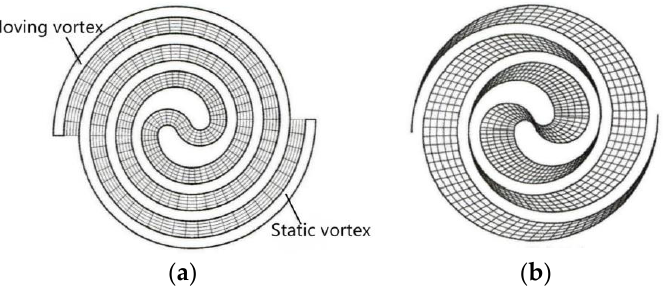
Figure 27. Structured dynamic meshes [116]. ( a ) Mesh generation; ( b ) mesh movement.